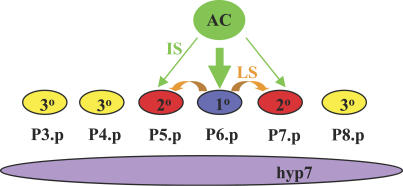
Signaling Events Involved in VPC Fate SpecificationIS, inductive signal; LS, lateral signal.